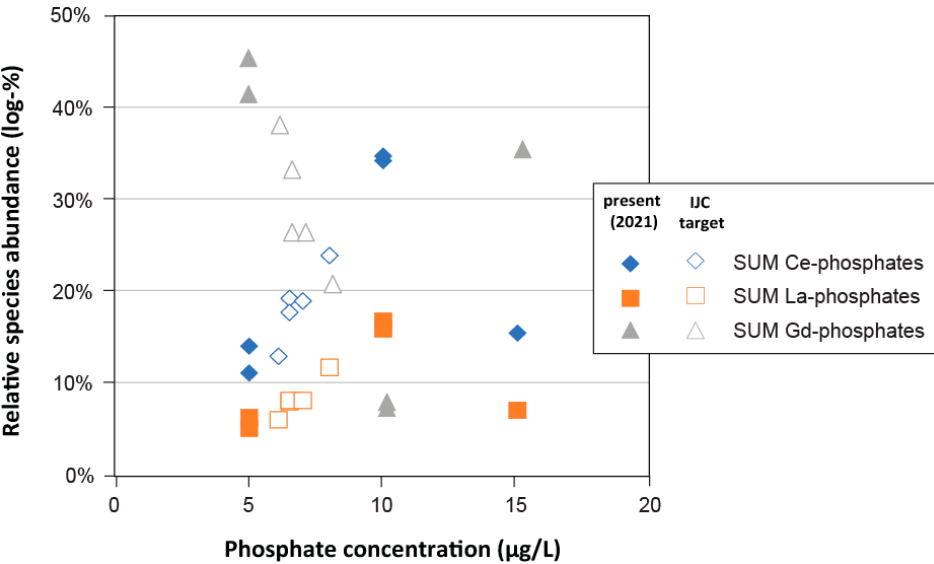
Figure 6. Geochemical equilibrium modelling of the relative abundance of aqueous phosphate complexes of La, Ce and Gd in the various connecting channels in the Great Lakes basin. Plotted is the share of aqueous rare earth element phosphate species per-total (molality basis) as a function of the phosphate concentration (present versus IJC targets; x-axis).